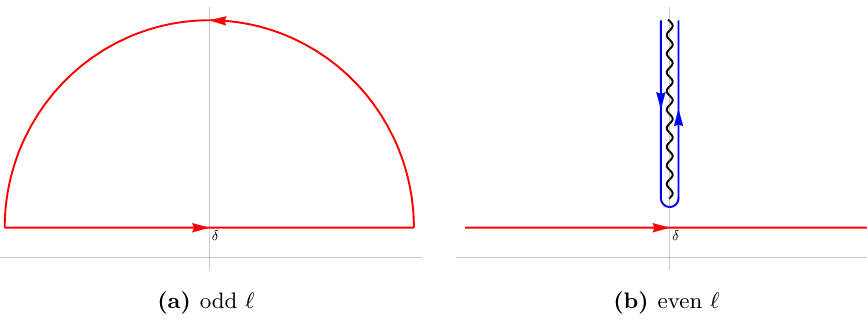
Figure 2. Contour for the integral I (cid:15) ( k, ‘ ) . When ‘ is odd, the contour is closed at infinity. When ‘ is even, the red contour in deformed to the blue one running along the branch cut of